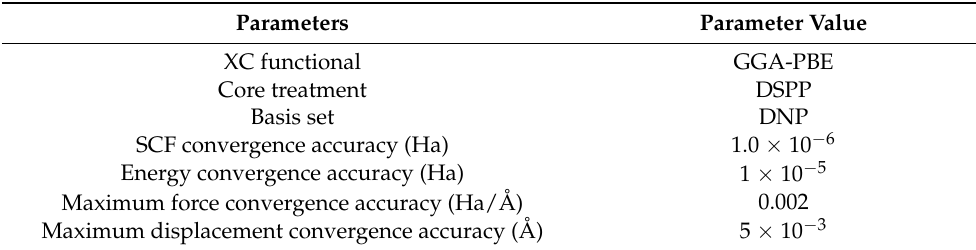
Table 1. Calculation parameters set in this paper.